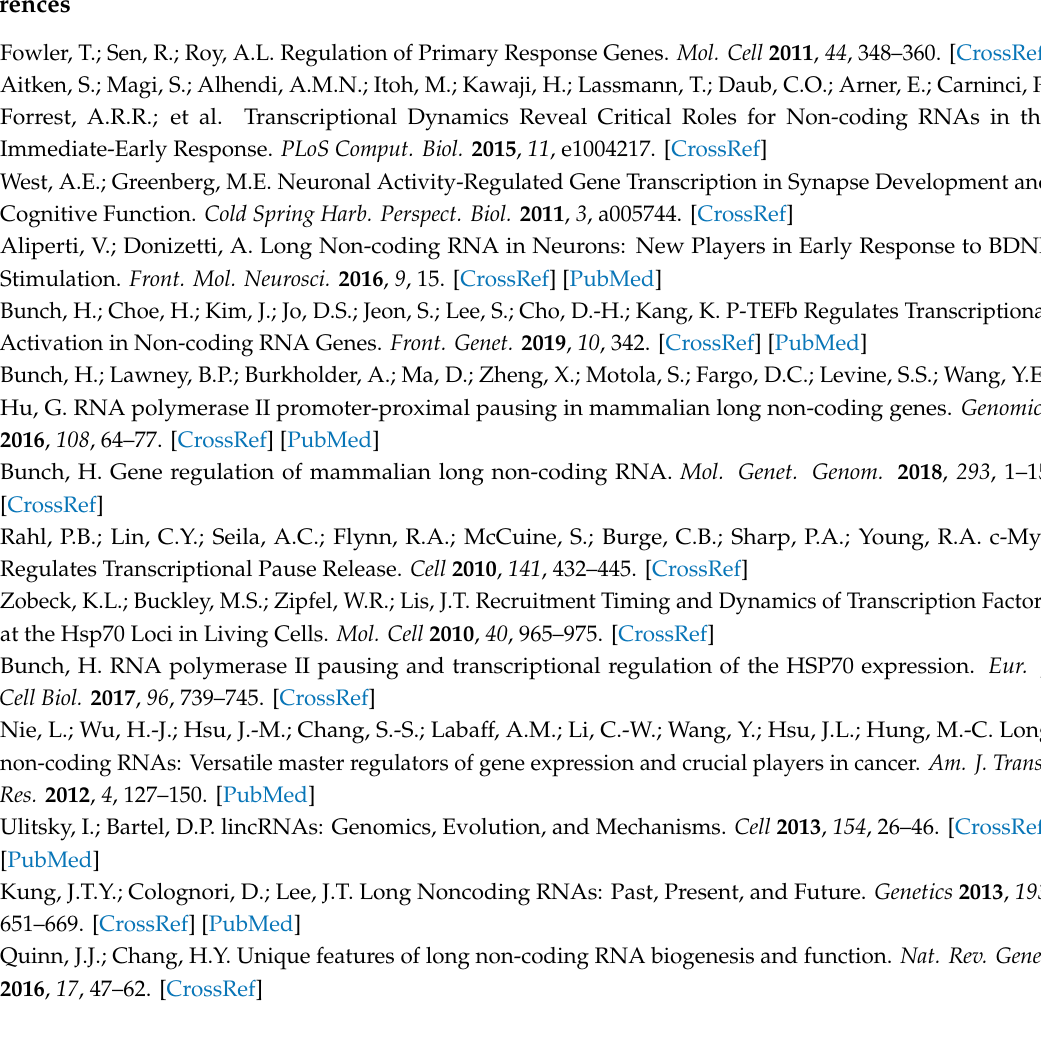
Figure S1: Basic elements of the CRISPR / Cas9 technology used to knockout the EGR1 gene and validation of the EGR1 KO cell line; Table S1: Expression level of the reference gene Glyceraldehyde-3-phosphate dehydrogenase (GAPDH) in di ff erent experimental conditions; Table S2: Sequences of gRNAs, genotyping primers and primers used for qPCR analysis; Table S3: Primary and secondary antibodies for western blotting